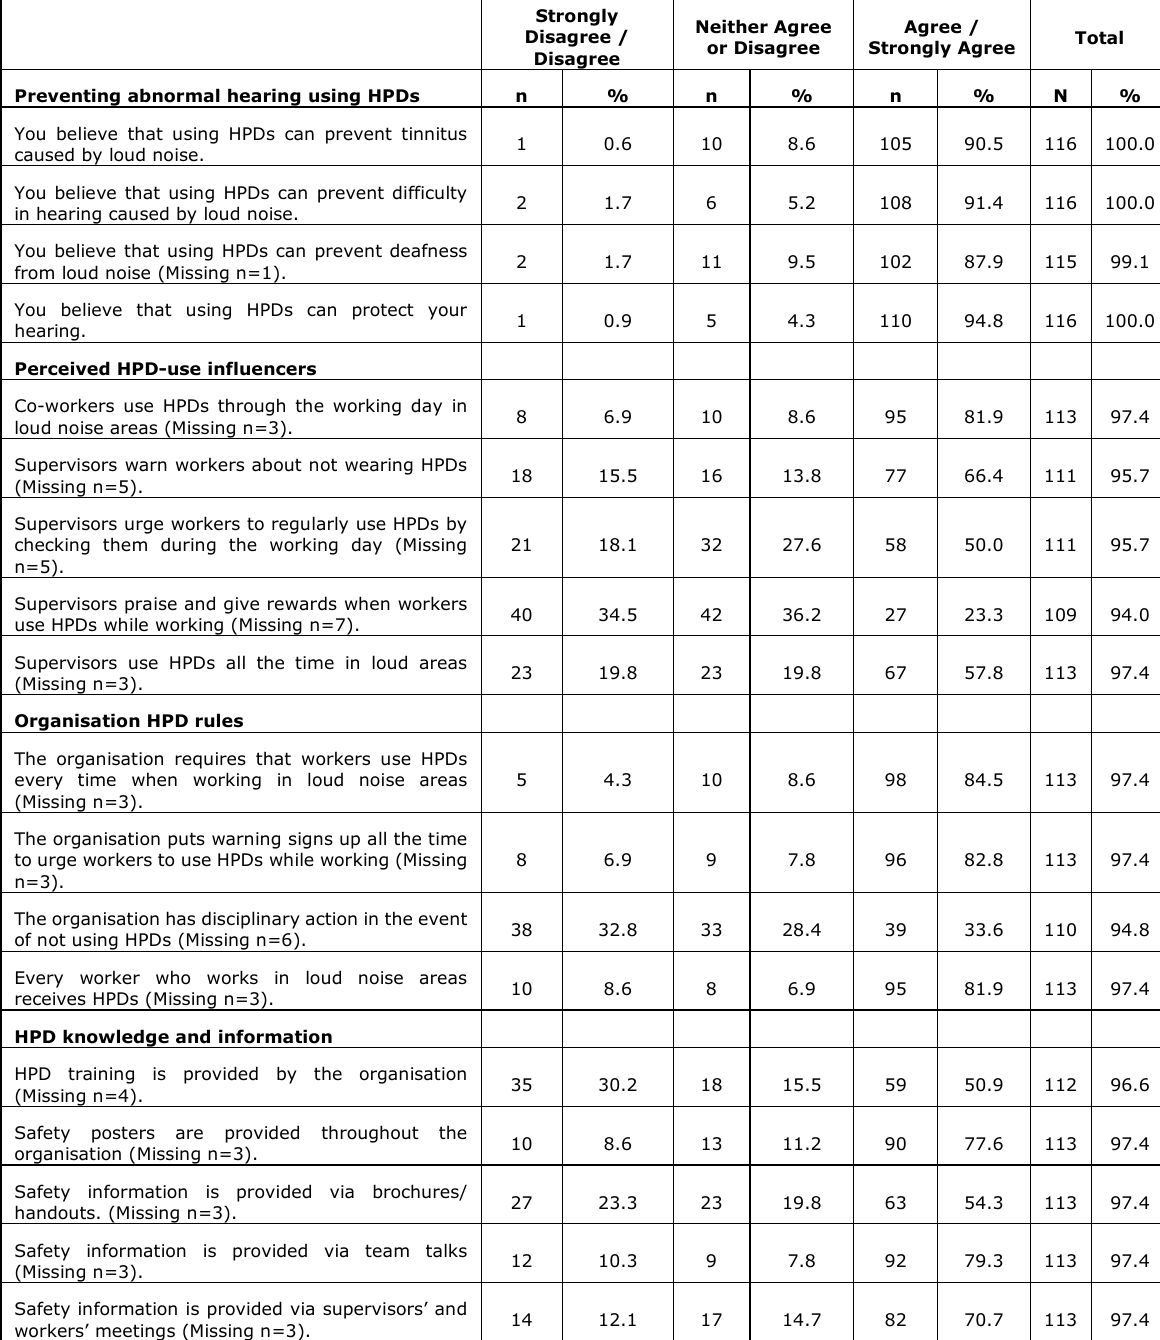
Table 2. Employee beliefs about HPD and organisational